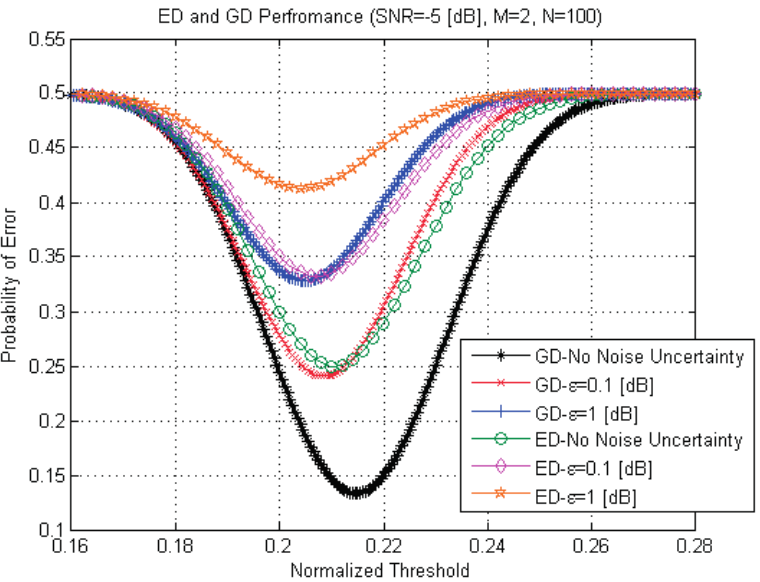
Figure 9. The probabilities of error GD σ = σ = σ threshold, 2 2 2 ξ η